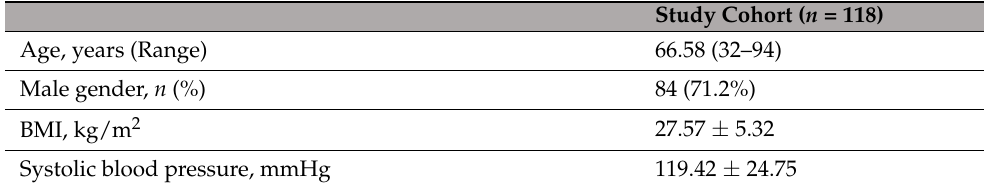
Table 1. Baseline